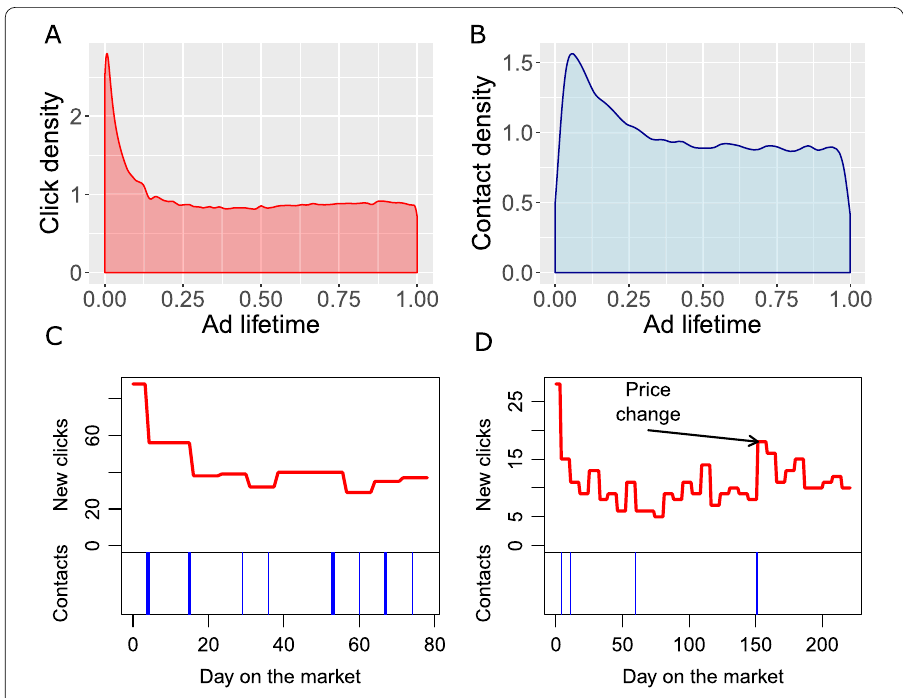
Figure 3 Temporal profile of clicks and contacts over the lifespan of ads. ( A )–( B ) Kernel density plots of the normalized times at which clicks/contacts occur. Both are peaked at the beginning of the ad lifetime, but the peak is more pronounced in the case of clicks. ( C )–( D ) Sequence of clicks/contacts for two sample (non-representative) ads. Clicks are normalized on a daily basis and the curves are discontinuous due to the fact that we only observe weekly snapshots of the database. In panel ( D ) there was a rise of clicks corresponding to a downward price revision. Contacts are shown as a barcode (the width of the bars